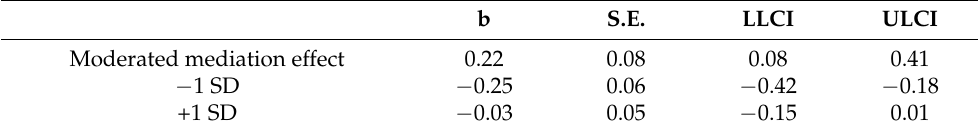
Table 5. Moderated mediation effects of job security on CWB via organizational